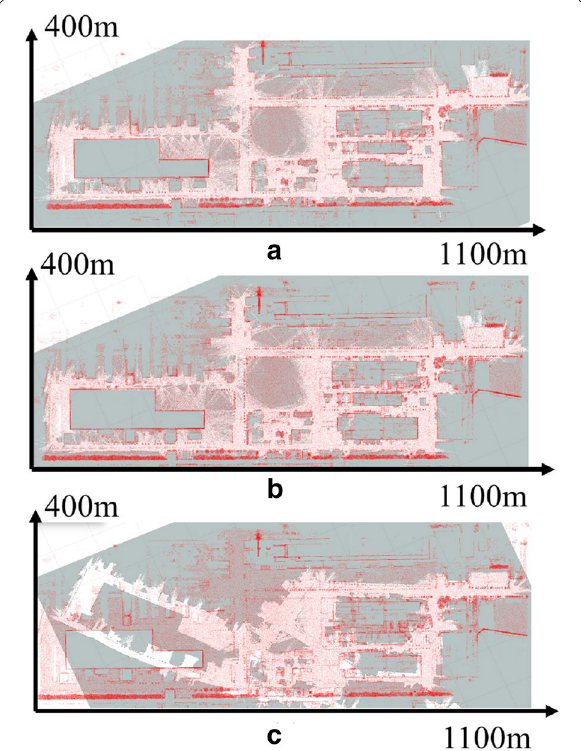
Fig. 20 Data in a factory where red is ground truth MMS data and the result of SLAM: a FS 2.0 based on GPS and LIDAR map and b FS 1.0 based on GPS and LIDAR map are observed to have consistency. However, c Karto SLAM based on LIDAR map has no consistency because large distortions are apparent on the